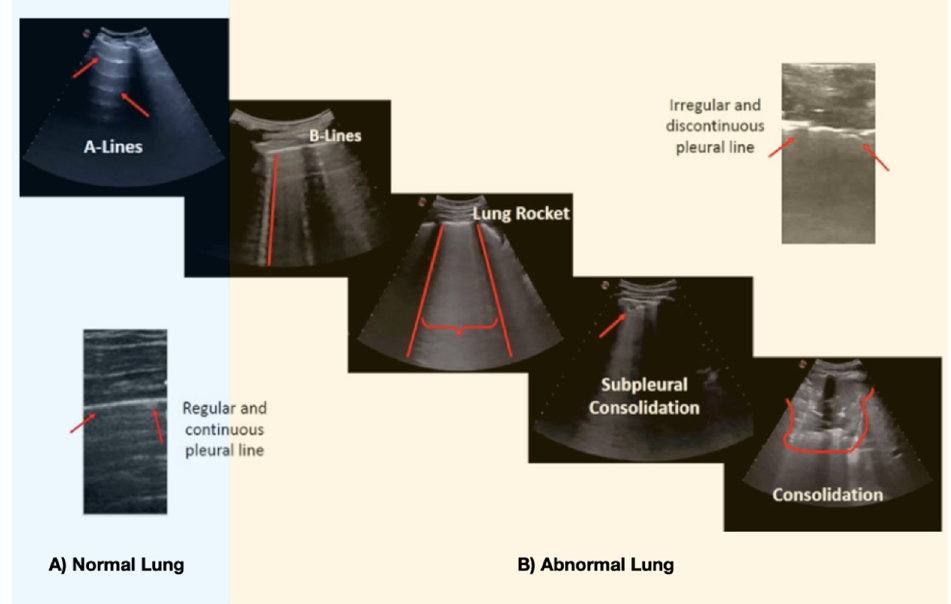
Figure 2. Main lung ultrasound findings in COVID-19 pneumonia. ( A ) Normal lung pattern of horizontal (red arrow) lines parallel to pleura (A-lines). ( B ) Abnormal Lung: B-lines: Pattern of vertical lines that reach the depth of field and start from the pleural line (red line). Lung Rocket: A “white lung” (braces) where the B lines converge inside an intercostal space (rib shadow—red lines). The pleural line is usually fragmented and irregular. If the pleural line increases the irregularity, it might generate a subpleural consolidation. If the subpleural consolidation (<1 cm) progresses, or in superinfection cases, big consolidations (>1 cm)